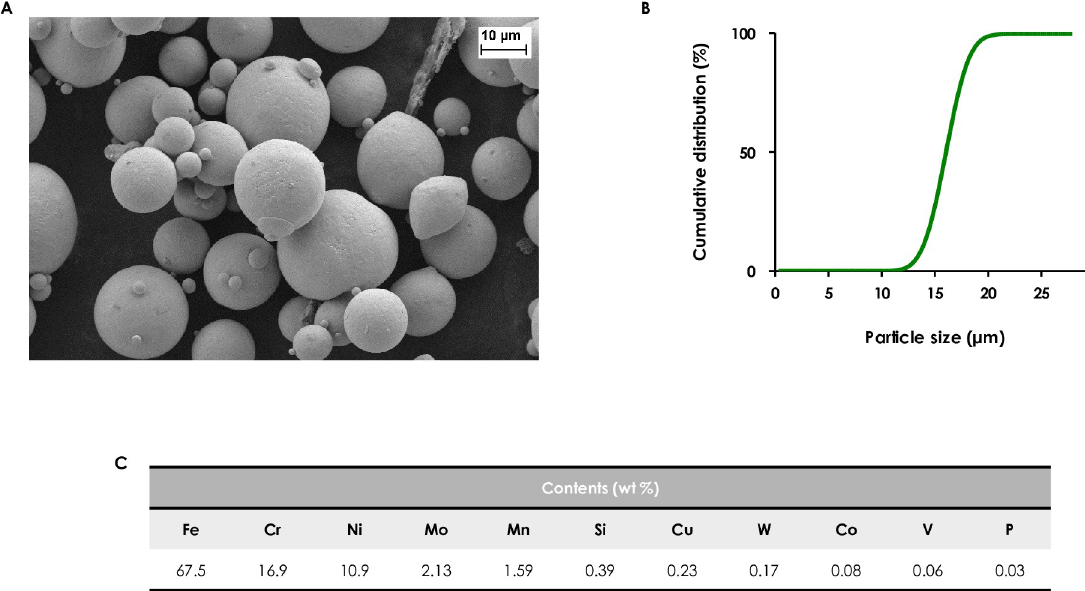
Fig 2. Characterization of 316L steel powder. (A) SEM micrograph; (B) particle size distribution; (C) elemental composition.